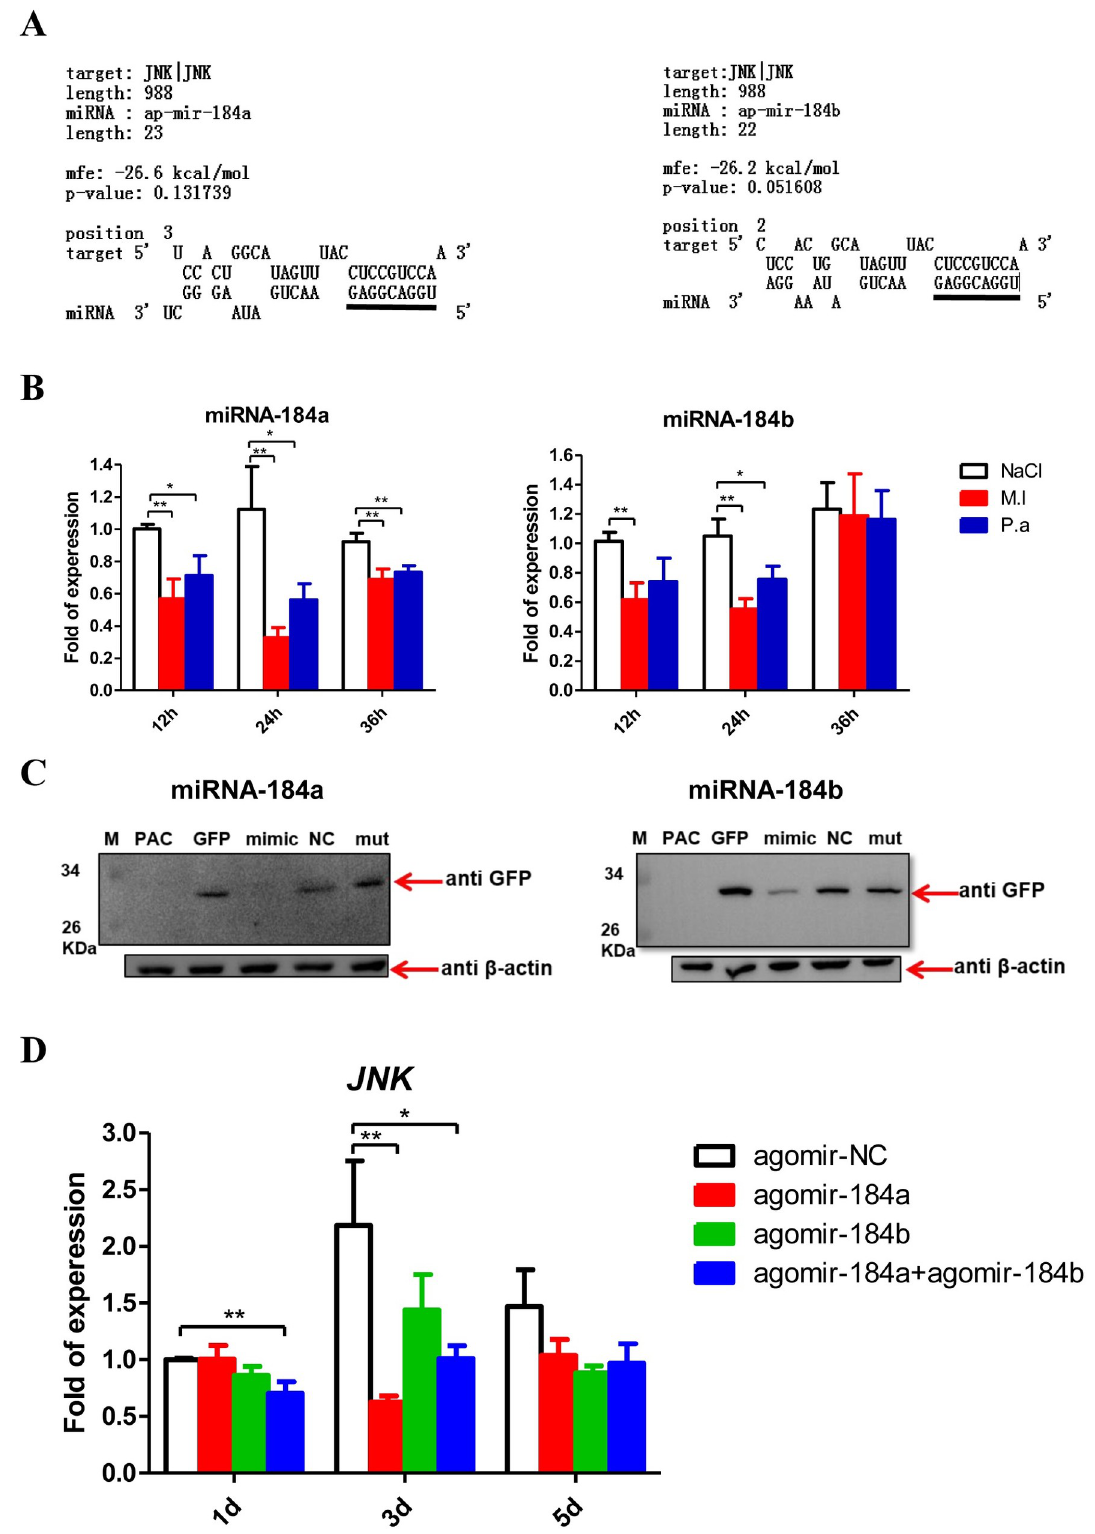
Fig 5. miR-184a/b target and negatively regulate JNK. (A) The putative miR-184a and miR-184b target binding site in 3 0 UTR of JNK is predicted by using RNAhybrid. The sequences in the lines above were seed region (5 0 GGACGGA3 0 ) binding sites predicted.